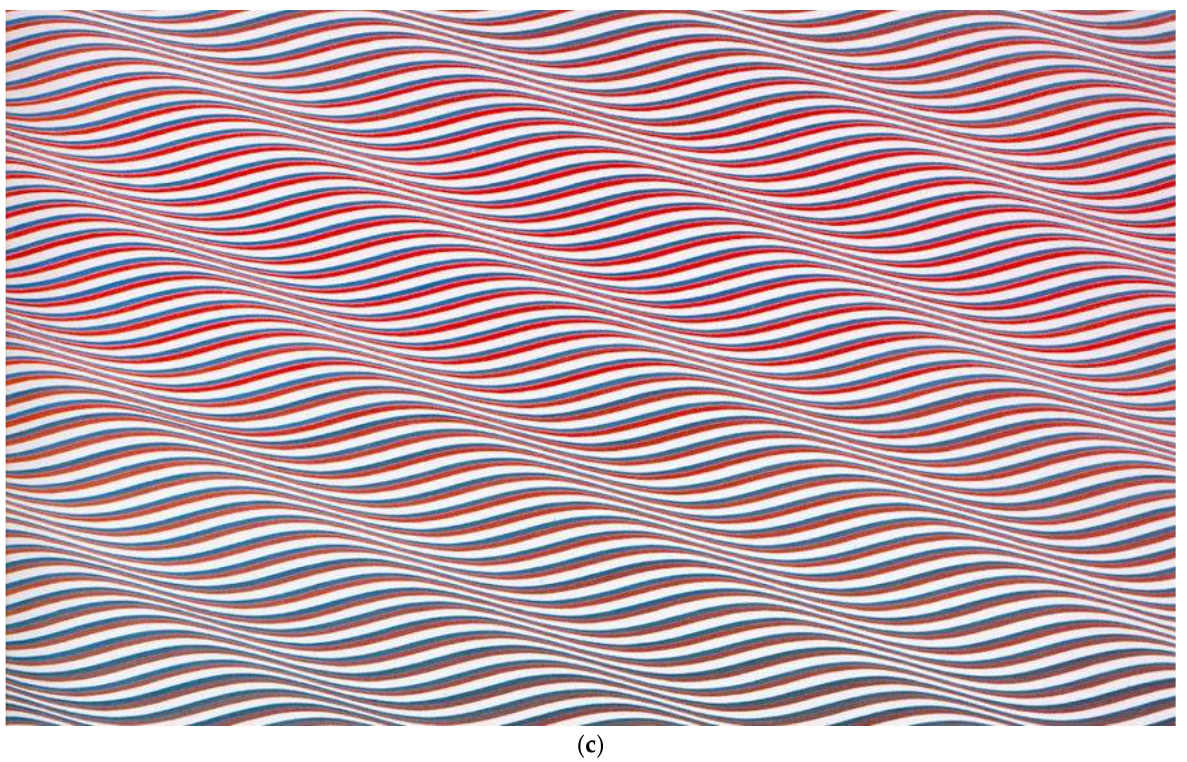
Figure 1. ( a ) Painting 1: Bridget Riley, Blaze 1 , 1962 © Bridget Riley 2022. All rights reserved. ( b ) Painting 2: Bridget Riley, Movement in Squares, 1961 © Bridget Riley 2022. All rights reserved. ( c ) Painting 3: Bridget Riley, Cataract 3 , 1967 © Bridget Riley 2022. All rights reserved.